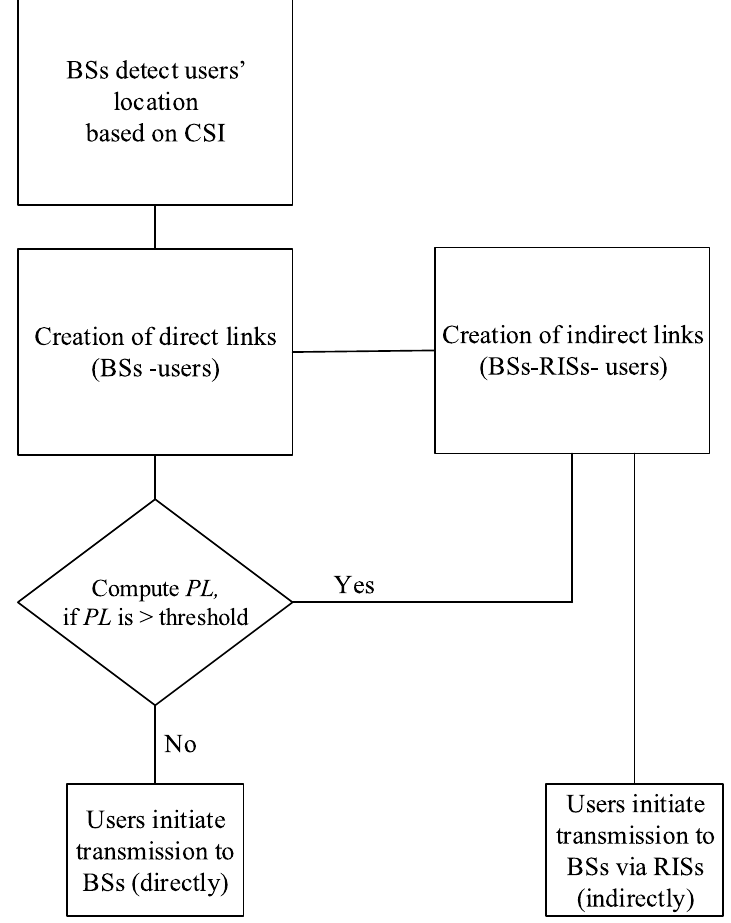
Figure 3. Flow chart diagram of the working principal of the 2D